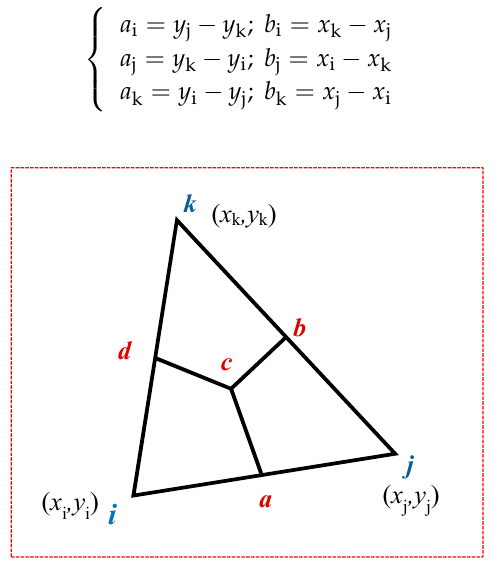
Figure 7. The typical triangle element.